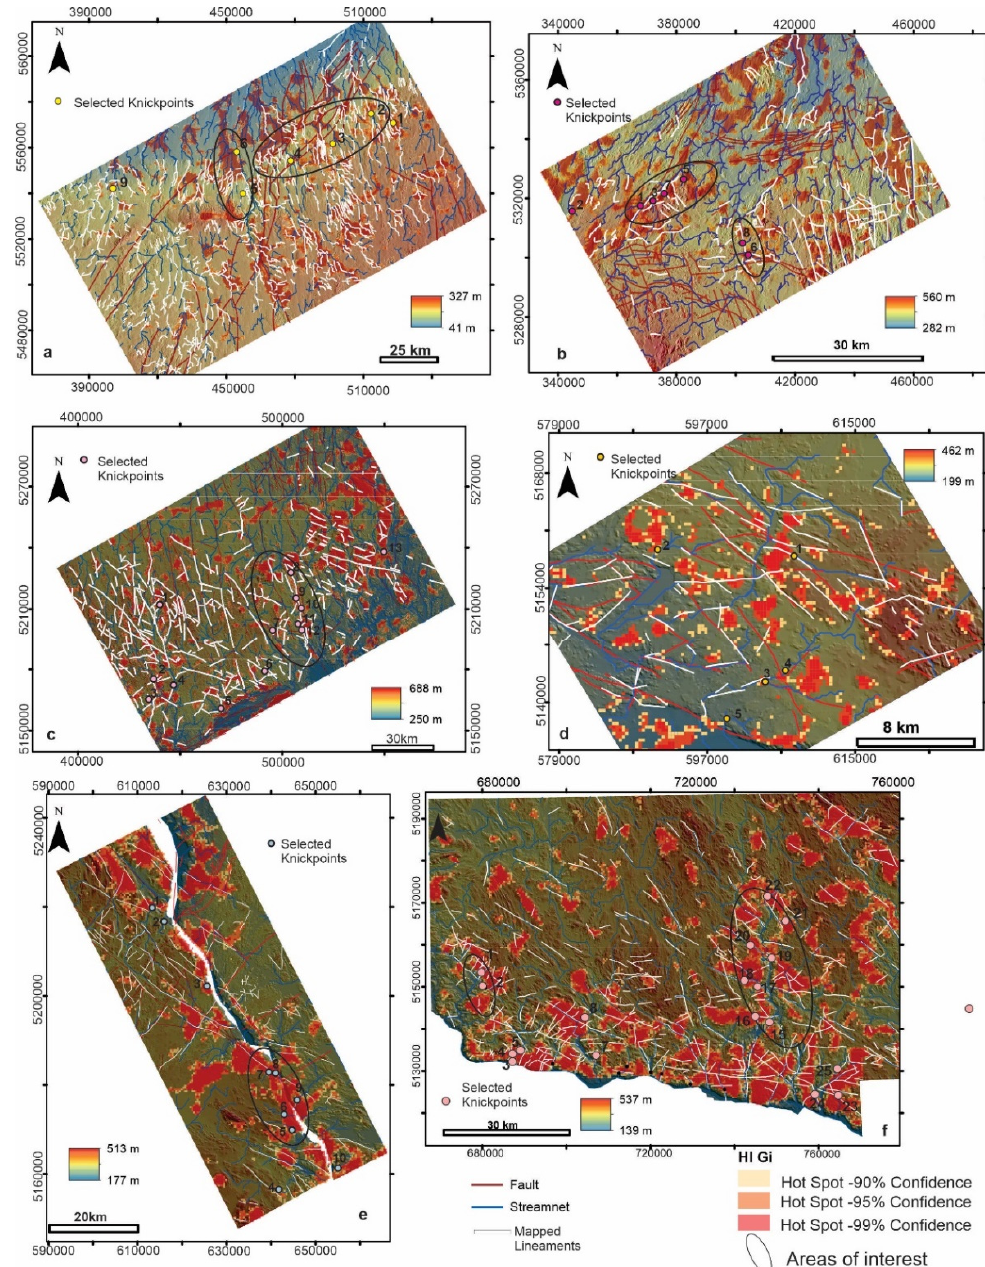
Figure 10. Final maps of areas of active deformation obtained in this study according to the workflow illustrated in Figure 9 for ( a ) subset 1, ( b ) subset 2, ( c ) subset 3, ( d ) subset 4, ( e ) subset 6, ( f ) subset 7. Black ovals identify Areas of Interest, clusters of knickpoints that have a higher potential to reflect underlining neotectonic structural features.